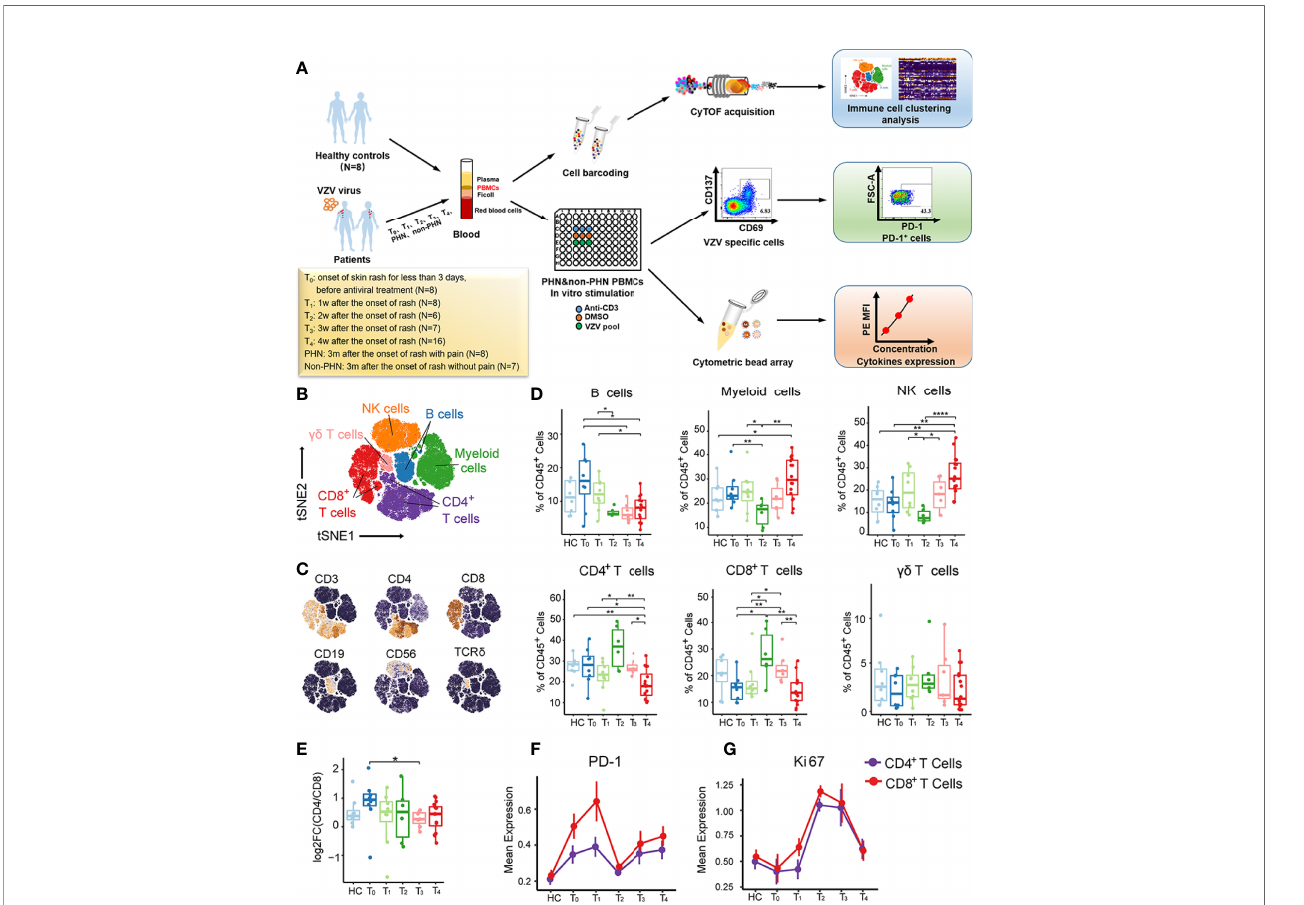
FIGURE 1 | Immune cell pro fi les of PBMCs from patients with HZ revealed by CyTOF. (A) Experimental design of this project. (B) t-SNE plot identifying the six major immune cell populations from PBMCs, including CD4 + T cells, CD8 + T cells, gd T cells, NK cells, B cells, and myeloid cells. (C) t-SNE analysis de fi ning the immune cell populations according to the expression of the main surface markers. (D) Boxplots demonstrating the frequencies of the six major immune cells in CD45 + cells among healthy controls (HC) and patients with each time point. (E) Boxplots showing alteration of CD4/CD8 T cell ratio among HC and patients from T 0 to T 4 . (F, G) The kinetic features of cell markers with PD-1 (E) and Ki67 (F) in both CD4 + T cells and CD8 + T cells. *P < 0.05, **P < 0.01, ****P <